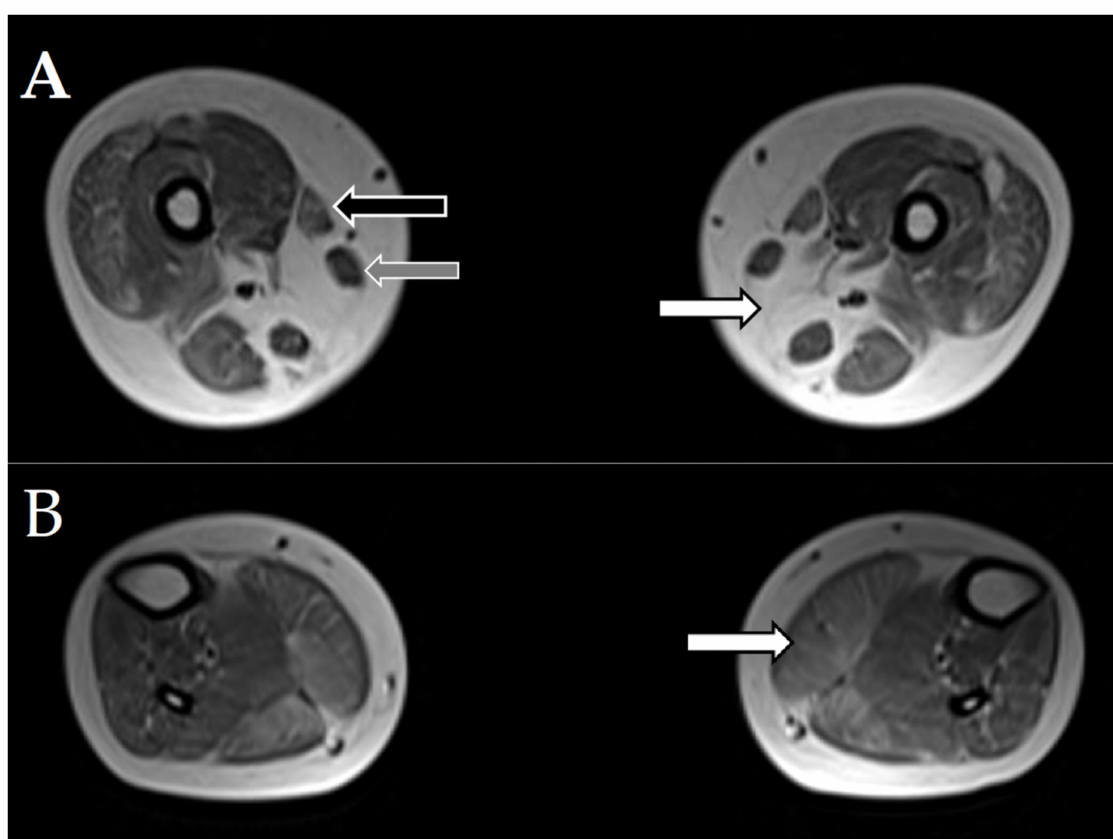
Figure 2. Magnetic resonance imaging (MRI) of muscles of patients 7 and 8a with SELENON mutations. Selected axial T1W images of the muscles. ( A ). White arrow points to the absence of the semimembranosus muscle. Black arrow points to the moderately affected sartorius muscle. Grey arrow points to the intact gracilis muscle. ( B ). White arrow points to moderate, diffuse changes in the gastrocnemius